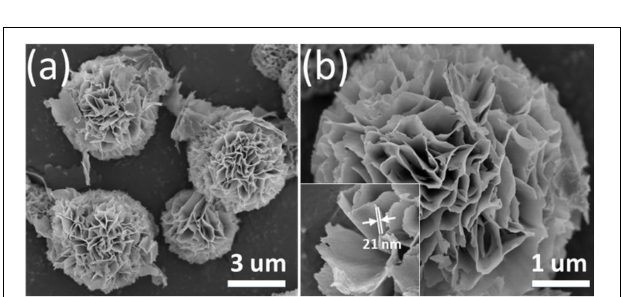
FIGURE 6 | Gas responses of flake-flower NiO based gas sensor toward 5 ppm CO at different temperature from 100 to 400 ◦ C.